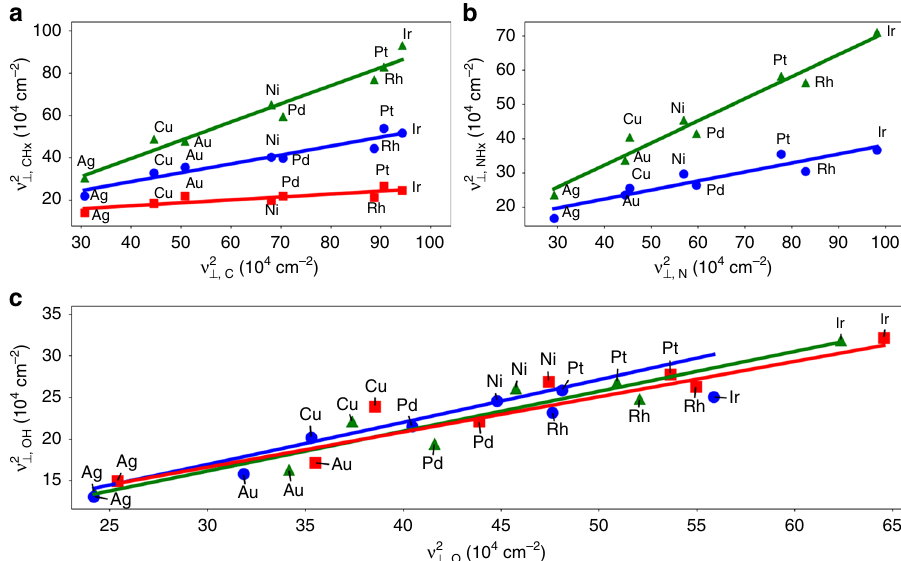
Fig. 1 Scaling of the ν ⊥ modes for AH X adsorbates with their atomic counterparts from DFT. Species are a CH X , b NH X , and c OH X . Adsorption is on the atop site of (100) transition metal surfaces. For a and b , respectively: green triangles = CH and NH, blue circles = CH 2 and NH 2 , and red squares = CH 3 . For OH X species c , ν ⊥ frequencies on the (110) and (111) facets are also included and green triangles = (100), blue circles = (111) and red squares = (100). The slopes of the regressed lines in a are 0.14, 0.42, and 0.86 for the red, blue, and green lines, respectively. In b , the slopes of the regressed lines are 0.26 and 0.64 for the blue and green lines, respectively. In c the slopes of the regressed lines are 0.43, 0.42, and 0.48 for the red, blue and green lines, respectively. All intercepts are